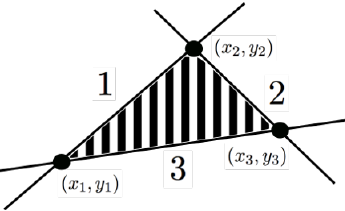
Figure 1 . Three lines in CP 2 (cid:3) labeled by i corresponding to three points f Z (cid:11) intersection of lines i and j is denoted by f i; j g . We note that f i; j g = f j; i g implicitly.